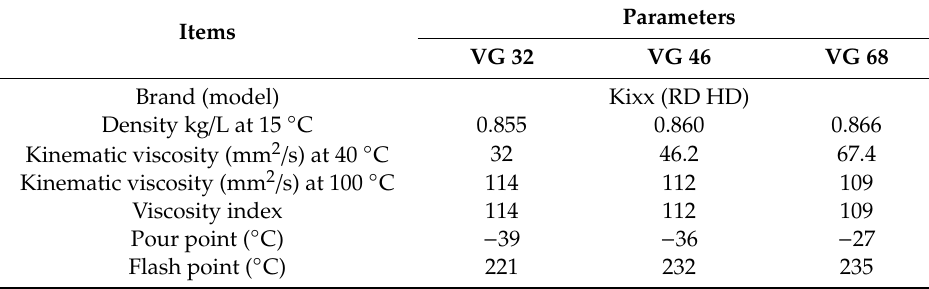
Table 1. Specifications of the selected hydraulic oils.